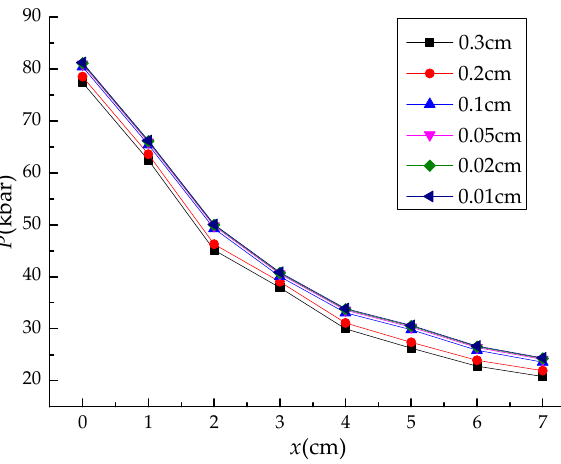
Figure 5. Attenuation curves of the shock wave pressure along the impact line at different mesh sizes.